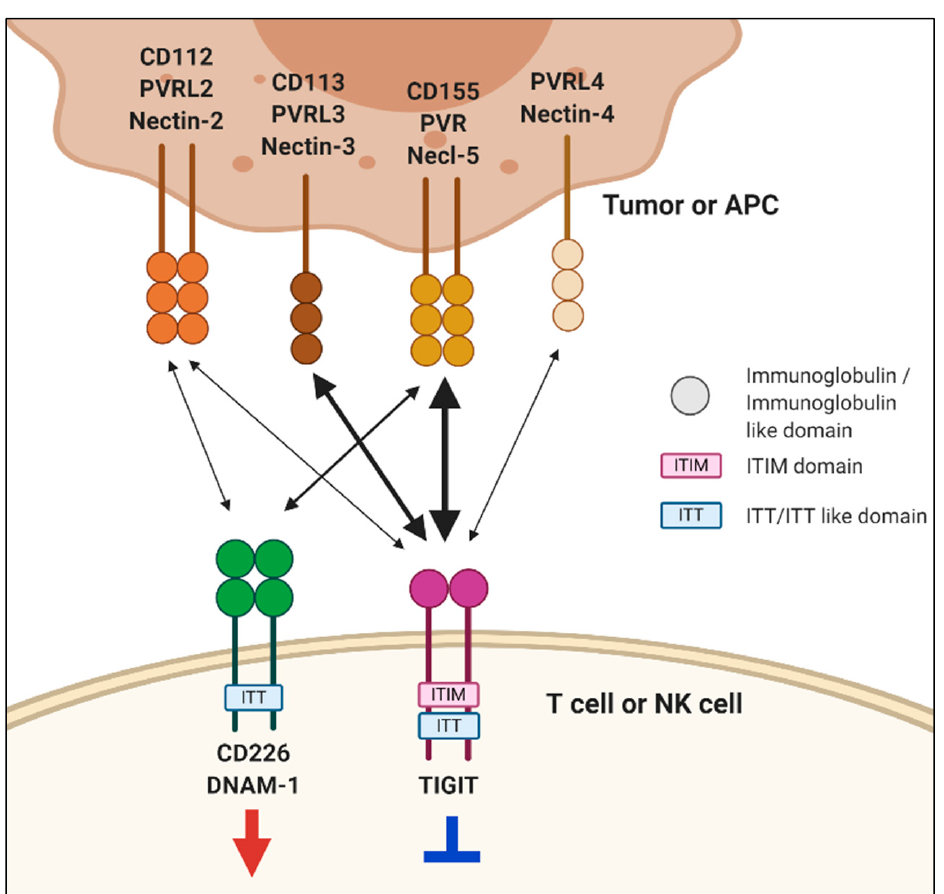
Figure 1. Interactions of T cell immunoreceptor with Ig and immunoreceptor tyrosine-based inhibitory motif (ITIM) domains (TIGIT) and CD226 with nectin and nectin-like molecules. TIGIT and CD226 are mainly expressed on T and natural killer (NK) cells. TIGIT has multiple ligands, including poliovirus receptor (PVR), nectin-2, nectin-3, and nectin-4. TIGIT binds to nectin-2 and nectin-3 with lower affinity than PVR. Upon engagement, TIGIT transmits inhibitory signals through ITIM and immunoglobulin tyrosine tail (ITT)-like motifs in its cytoplasmic domain. CD226 interacts with PVR and nectin-2 to deliver a positive signal. TIGIT binds to PVR with higher affinity than CD226. The integrated signals formed by their complex interactions regulate immune-cell functions, which is important for immunity and inflammatory responses. Interactions between receptors and ligands are depicted by two-sided arrows. The arrows are proportional to the reported affinities of the interactions except nectin-4.